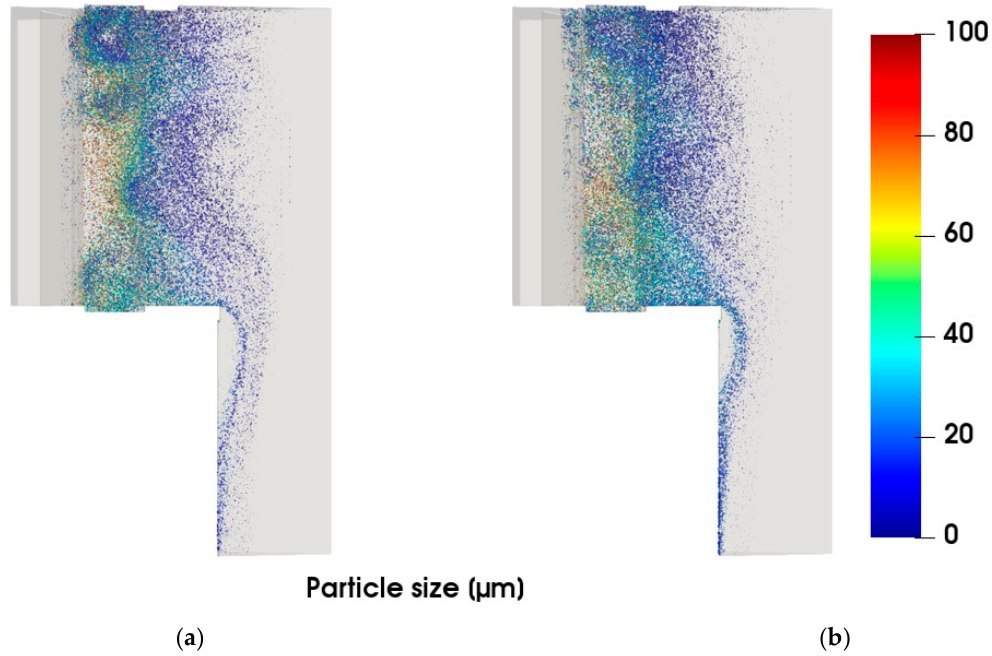
Minerals 2021 , 11 , 663